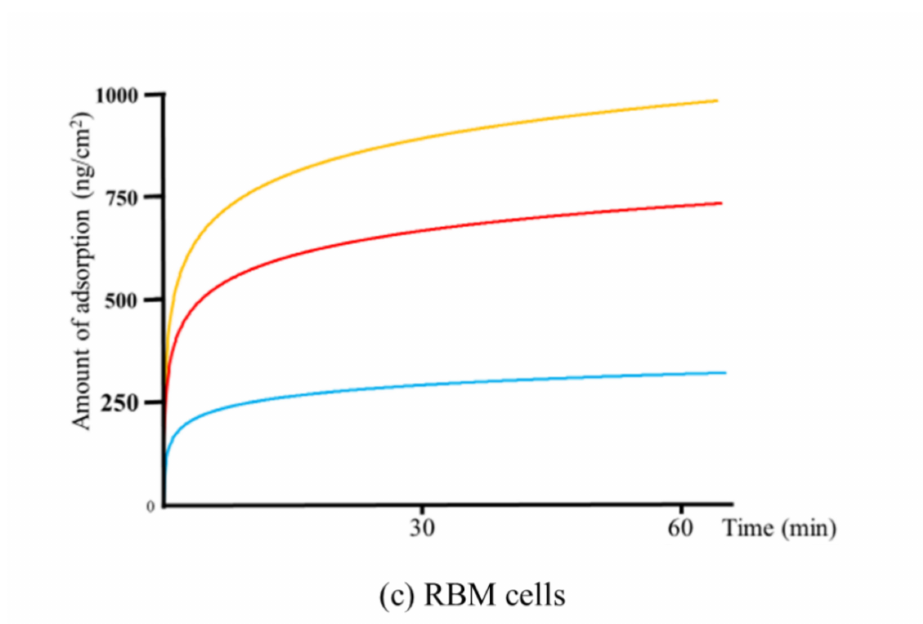
Figure 5. Changes in the adsorption over time of ( a ) albumin, ( b ) fibronectin, and ( c ) rat bone marrow (RBM) cells on (blue) untreated, (red) UV-treated, and (yellow) plasma-treated Ti-QCM